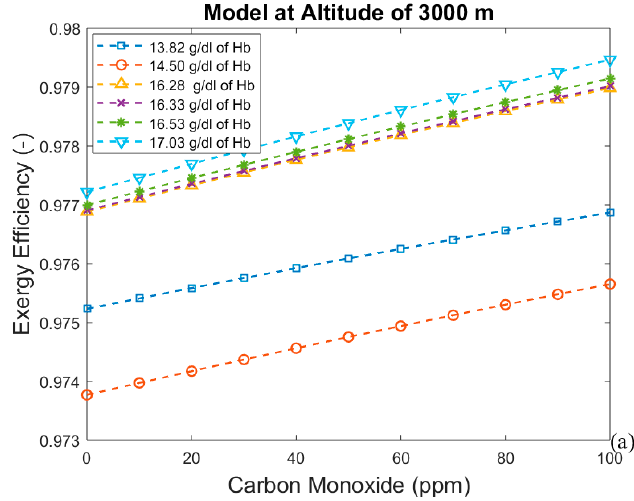
Figure 5. ( a ) Exergy efficiency and ( b ) destroyed exergy as functions of carbon monoxide and hemoglobin concentration at 1500 m.